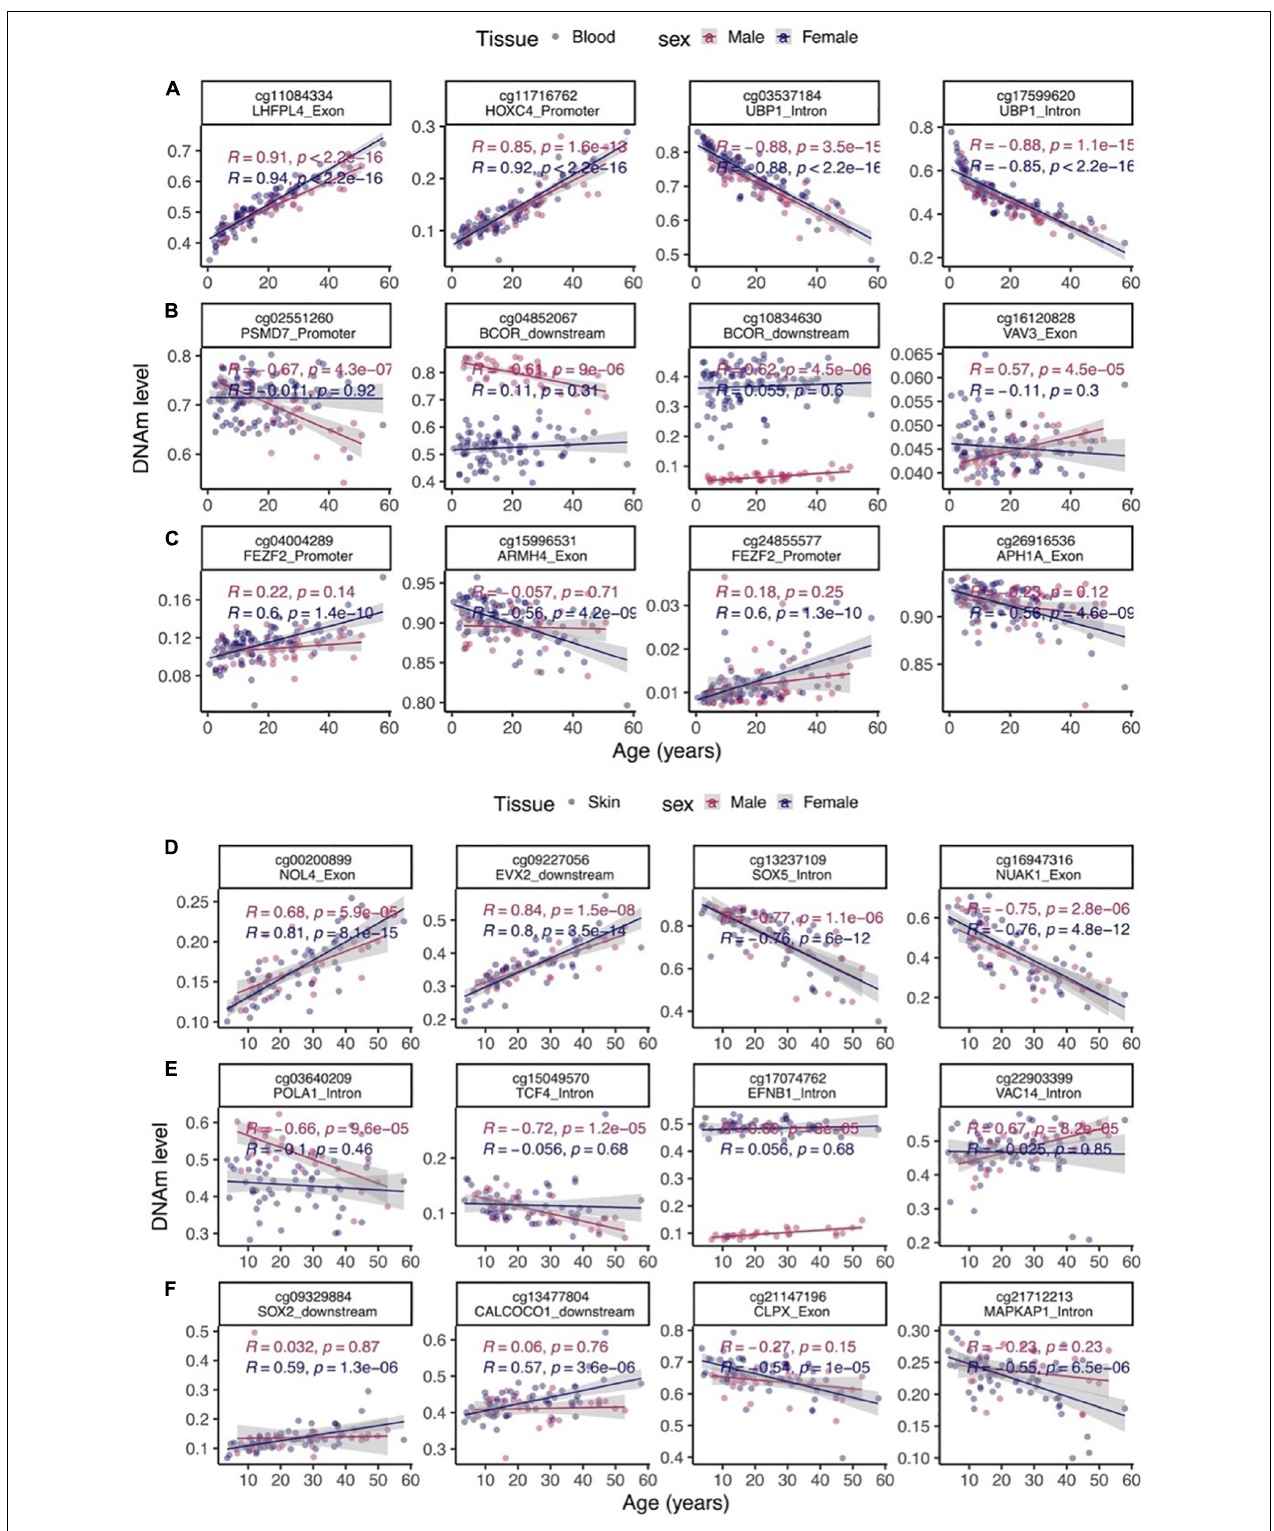
FIGURE 4 | Select age-related CpGs stratified by sex. (A) CpGs that change with age in male and female blood samples from bottlenose dolphins. (B) Male specific changes in blood. (C) Female specific changes in blood. (D) CpGs that change with age in both male and female skin. (E) Male specific changes in skin. (F) Female specific changes in skin. The ordinary least squares regression lines were carried out in males (red) and females (blue) separately.